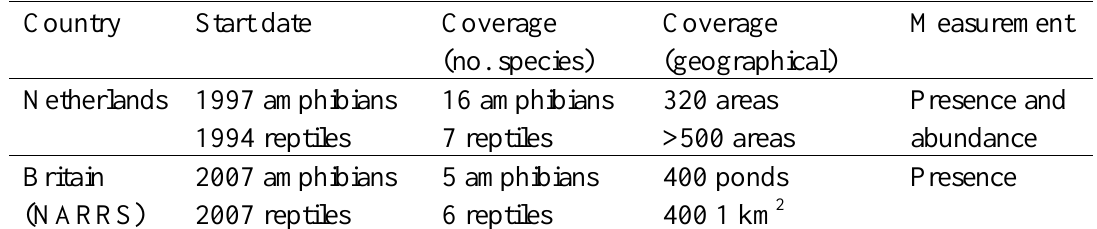
Table 7. Site network systems for species